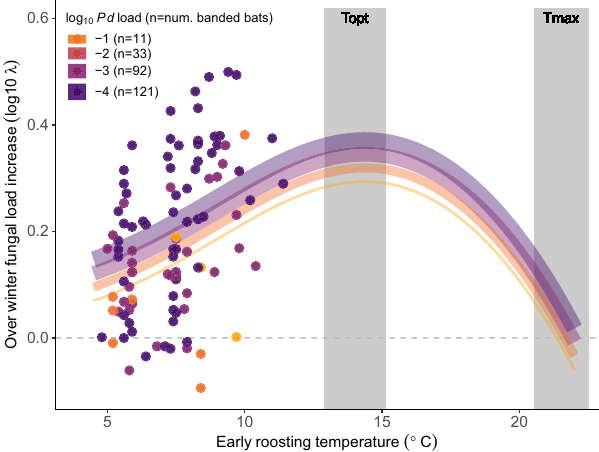
Fig. 3 Temperature and changes in fungal loads on bats. Observed fungal load changes on individual infected bats that were recaptured in late hibernation ( N = 123), where the curves depict the fi tted Logan-10 temperature-dependent growth curve with fungal-load-dependent intercepts. The shaded regions indicate the 95% credible intervals for the T T opt and max parameter estimates from the prior laboratory population growth rates decline with increasing average roosting temperature, whereas over summer population growth rates tend to increase with temperature, suggesting that bats preferentially immigrate to the warmer sites with the highest mortality. Fur- thermore, across 12 hibernacula surveyed before, during, and after invasion, half of the metapopulation still roosts in relatively warm microclimates post-invasion, even though cooler refuges are available.